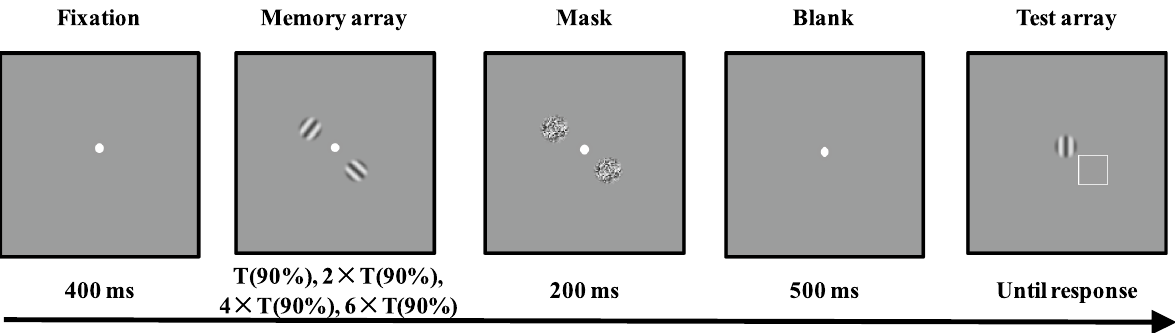
Figure 5. Trial structure of the main task in Experiment